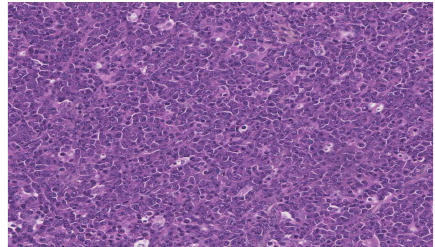
Figure 2: Breast lymphoma, microscopic aspects, HPS × 20.